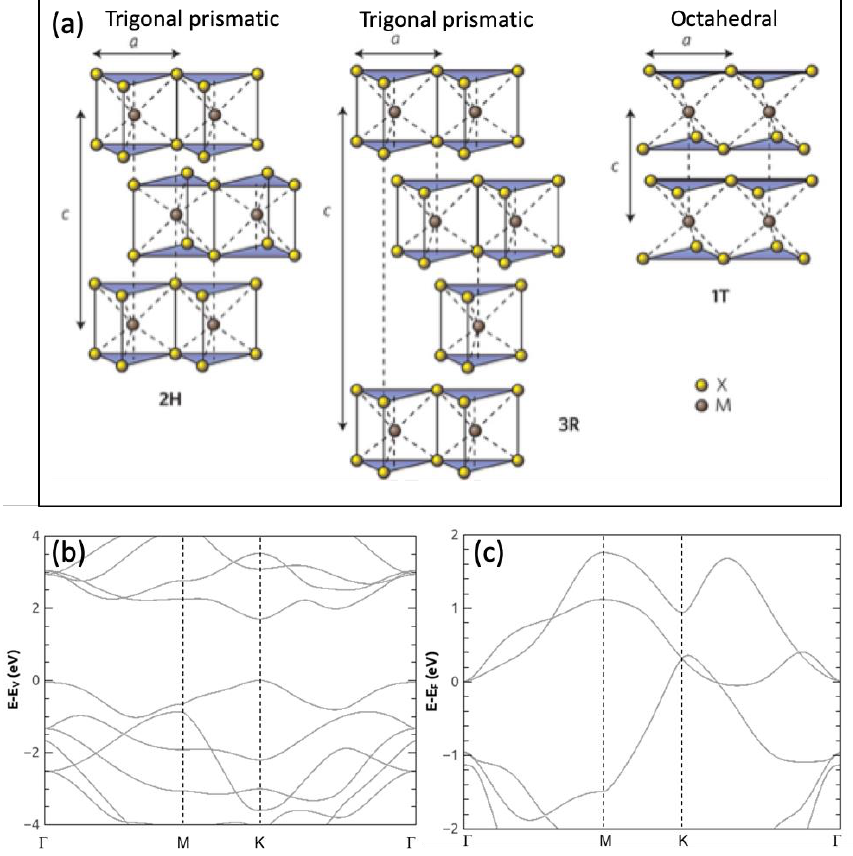
Figure 4. ( a ) Schematic representations of 2H, 3R, and 1T phases of transition metal dichalcogenides. ( b ) Computed electronic band structure of a 2H-MoS 2 monolayer. The reference energy level corresponds to the valence band edge. ( c ) Computed electronic band structure of a 1T-MoS 2 monolayer. The reference energy level corresponds to the Fermi level.